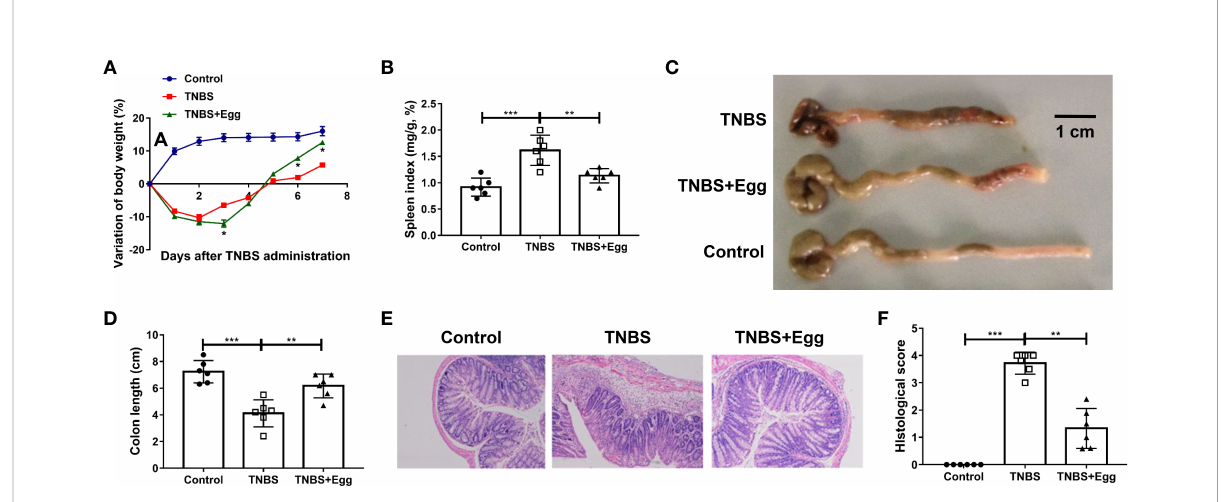
FIGURE 1 Pre-exposure to S. japonicum eggs alleviated the colon in fl ammation in the TNBS-induced experimental colitis. Female BALB/c mice were randomly divided into 3 groups: Control, TNBS, and TNBS+Egg. TNBS (0.5mg per mouse in 50% ethanol) was used by rectal instillation to induce colitis. Mice of the TNBS+Egg group were pre-exposed to S. japonicum eggs as a preventive intervention. (A) Dynamics of body weight variation at different time points. * P < 0.01, the TNBS group versus the TNBS+Egg group. All samples including B to F were collected on the 5th day after the TNBS modeling. (B) Spleen index. (C) Representative images of colons and (D) the statistical graphs of colon length. (E) Representative images of colon histopathology and (F) the statistical graphs of the colonic histological score. Data are expressed as means ± SEMs based on 6 mice in each group and from 2 independent experiments. Asterisks mark signi fi cant differences among different groups (** P < 0.01, *** P <